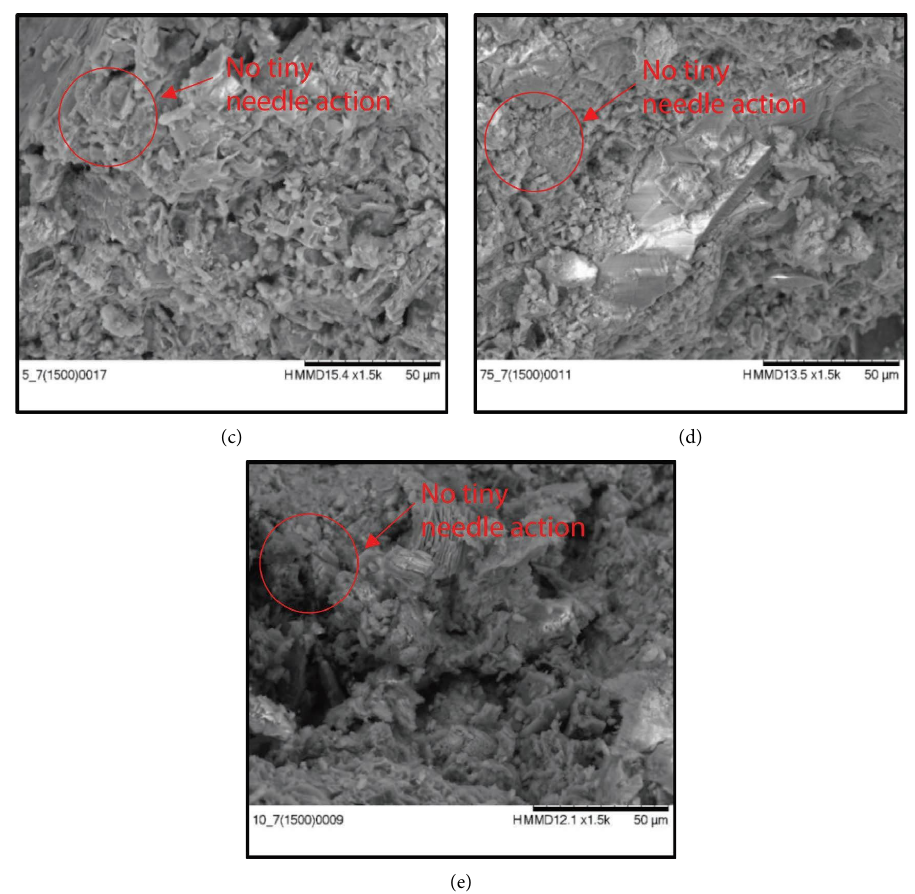
Figure 11: SEM micrographs of mortar on day 7 at 50 micron scale with 1500 magnifcations: (a) 0% POFA, (b) 2.5% POFA, (c) 5% POFA, (d) 7.5% POFA, and (e) 10%